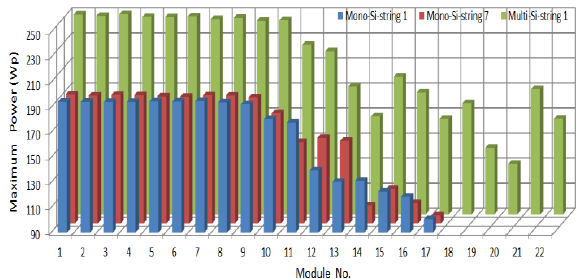
Figure 9. The change of the maximum output power for three module strings, which are monocrystalline silicon module string 1 and 7 of Figure 5a, and multicrystalline silicon module string 1 of Figure 5b, respectively.